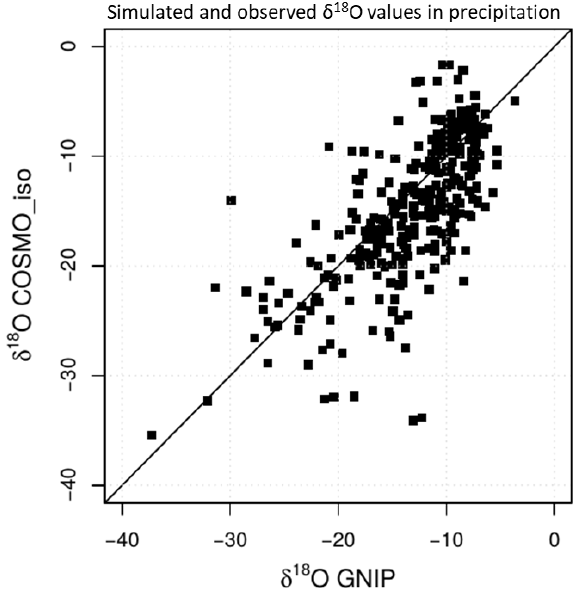
Figure 5. Monthly δ 18 O simulated with COSMO_iso_50km for the period 2008–2014 versus the corresponding observations for nine GNIP stations (Table